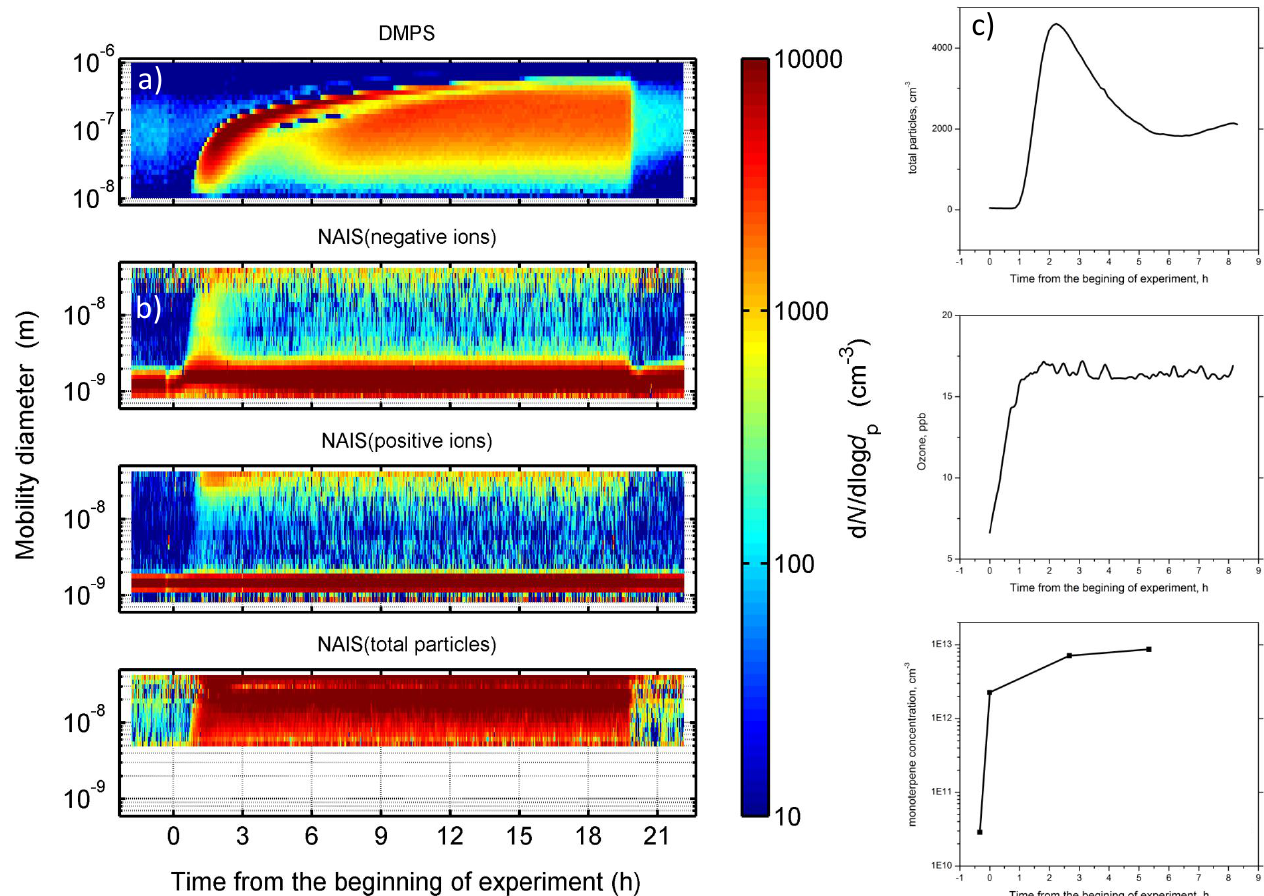
Fig. 2. α -pinene event measured on 10–11 November 2008. (a) a DMPS plot showing all particles (neutrals + charged) from 10 to 1000nm. (b) a NAIS plot showing particles from 0.8 to 40nm. Top: negative particles; middle: positive particles; bottom: neutral + charged particles. (c) Top: total number of particles percm 3 , middle: Ozone concentration in ppb , bottom: α -pinene concentration percm 3 .